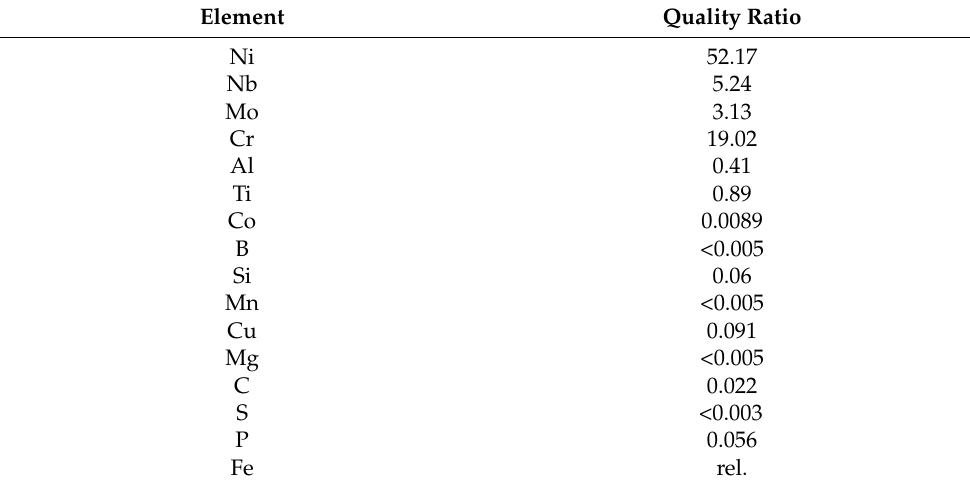
Table 3. Chemical composition of Inconel 718 powder (wt.%).